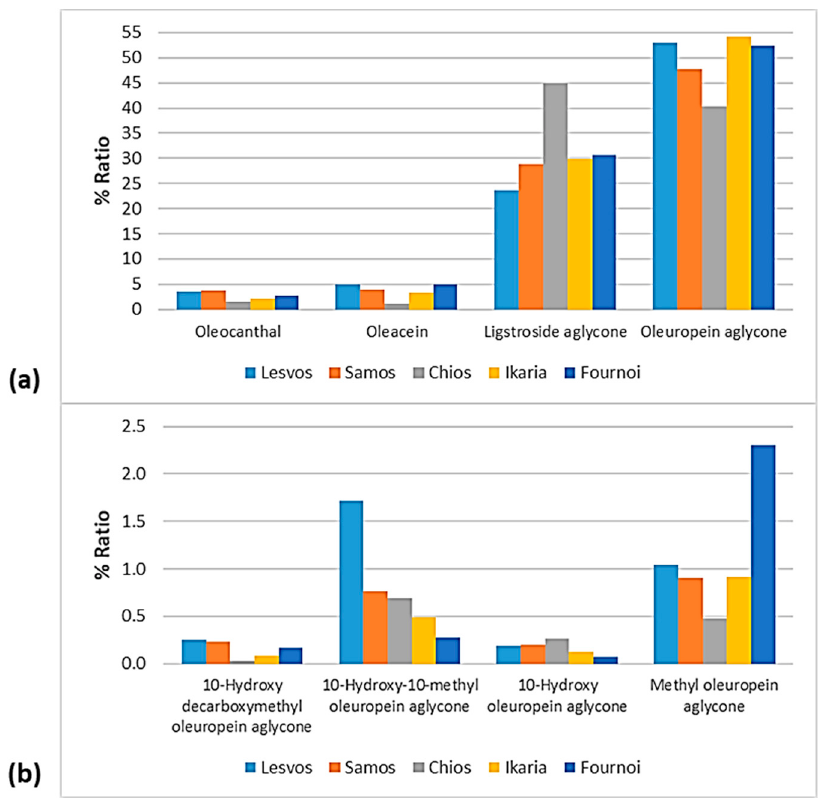
Figure 13. % Ratio of the secoiridoids ( a ) oleocanthal, oleacein, ligstroside aglycone, and oleuropein aglycone; and ( b ) methyl oleuropein aglycone, 10-hydroxy-10-methyl oleuropein aglycone, 10-hydroxy decarboxymethyl oleuropein aglycone, and 10-hydroxy oleuropein aglycone to the phenolic content in the EVOOs between the islands (Lesvos, Samos, Chios, Ikaria, and Fournoi) of the North Aegean Region.